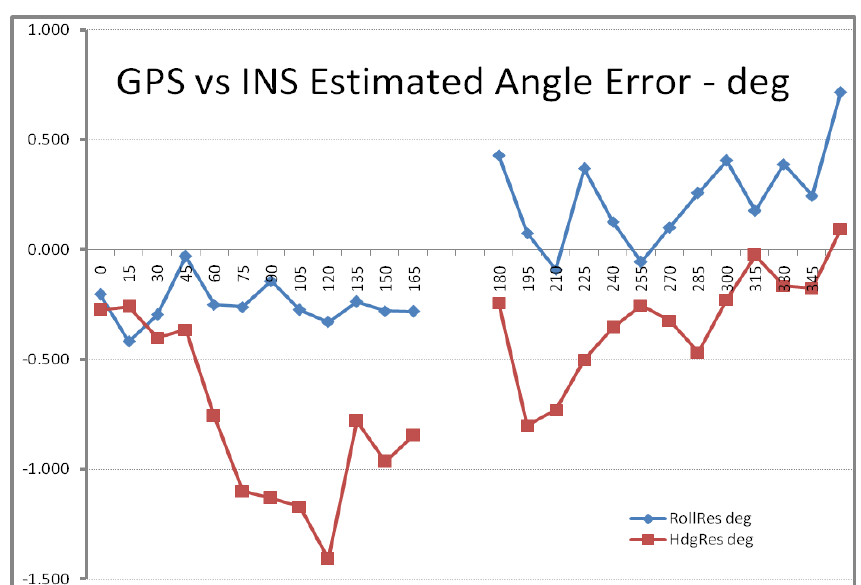
Figure 12. GPS Tilt and Azimuth Errors Compared to calculated instantaneous orientation angles using the mounted Inertial Navigation System (INS); one milli-radian accuracy is not achievable from a single GPS DAS observation justifying the need for multiple setups and the need for the algorithm